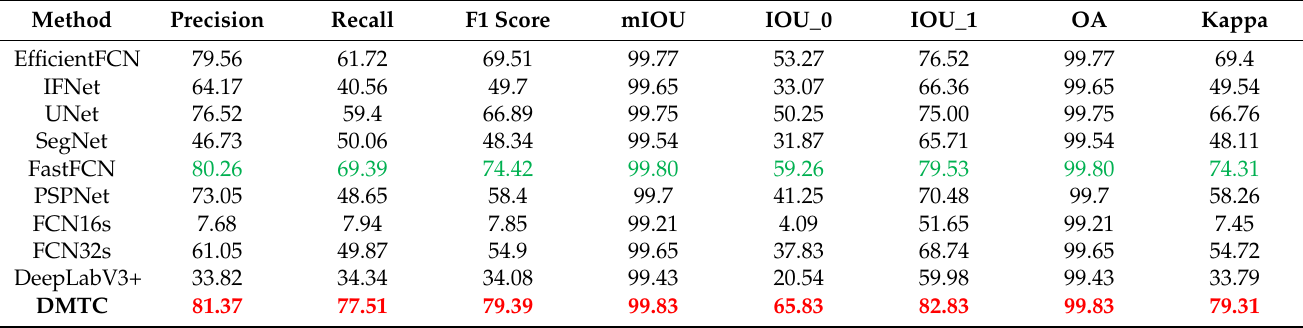
Table 1. The quantitative results of proposed method on CPRID.